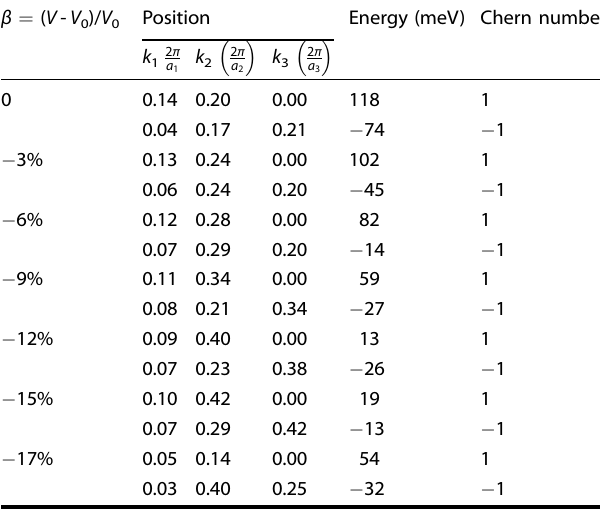
Weyl points upon compression.